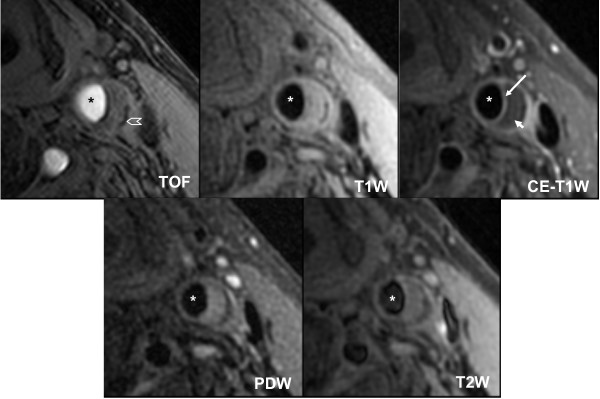
Atherosclerotic Carotid Artery Lipid-rich Necrotic Core. Multi contrast black and bright blood sequences show a large lipid-rich necrotic core (small arrow) with an intact thick fibrous cap best seen in the post contrast T1 weighted (CE T1W) image (long arrow). Calcification is also visible at the base of the plaque (chevron). Asterisks are placed on the lumen.